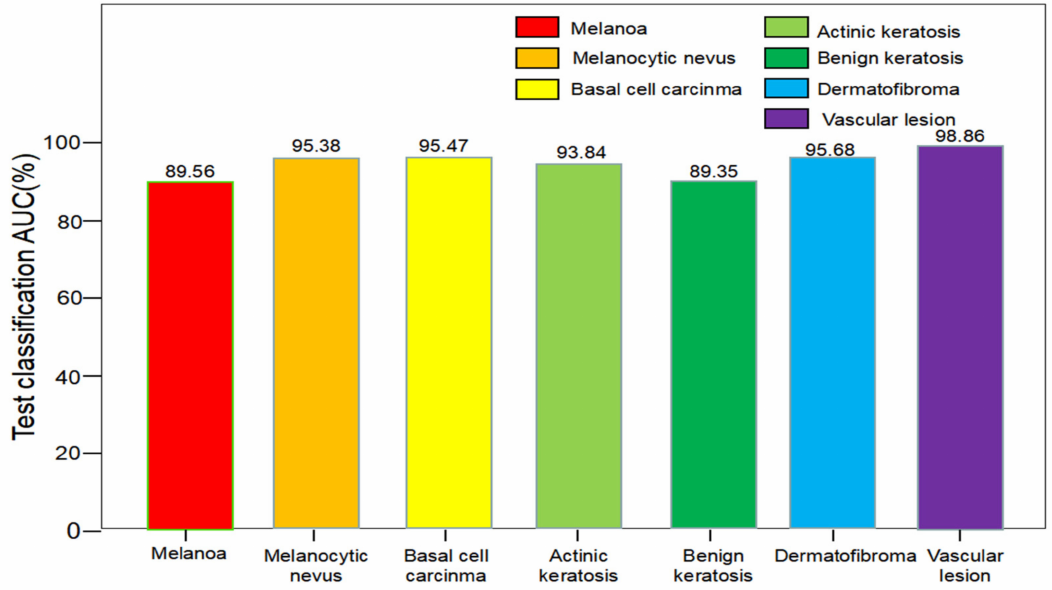
Figure 4. AUC performance of each category for the ISIC 2018